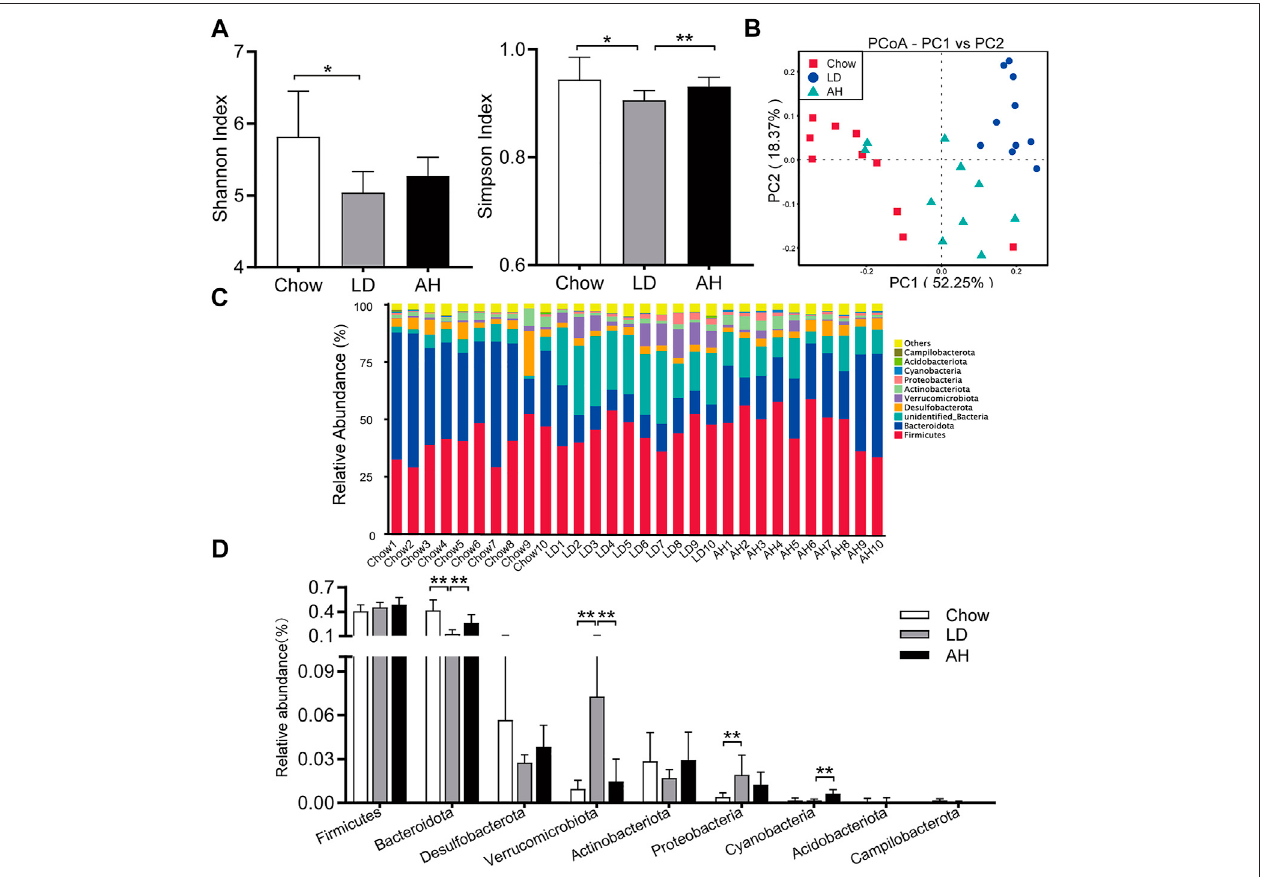
FIGURE 6 | APS changed the composition of the gut microbiota. (A) Shannon Index and Simpson Index. (B) Weighted Unifrac principal coordinate analysis (PCoA). (C, D) Multigroup difference analysis of the top-9 most abundant phyla. Data are the mean ± SD ( n (cid:2) 10). * p < 0.05, ** p < 0.01. Chow, chow diet; LD, lithogenic diet; AH, high-dose